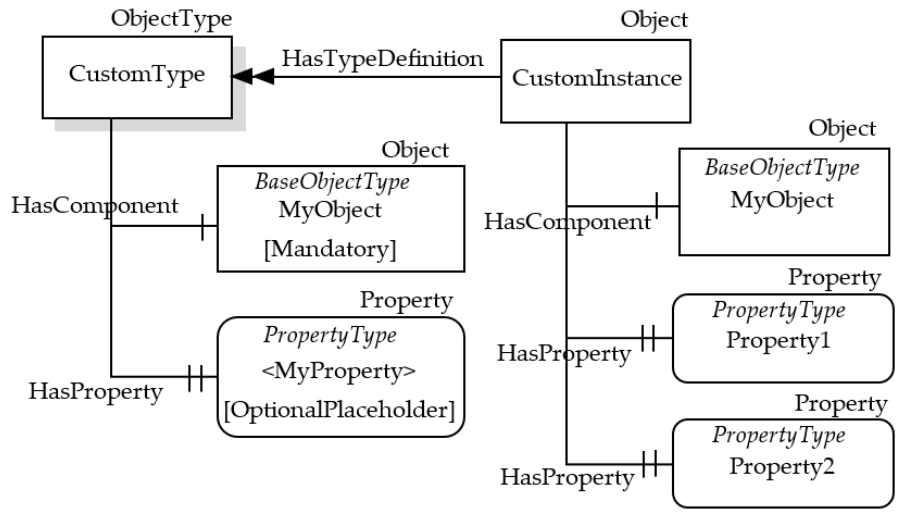
Figure 2. Example of OPC UA graphical representation.